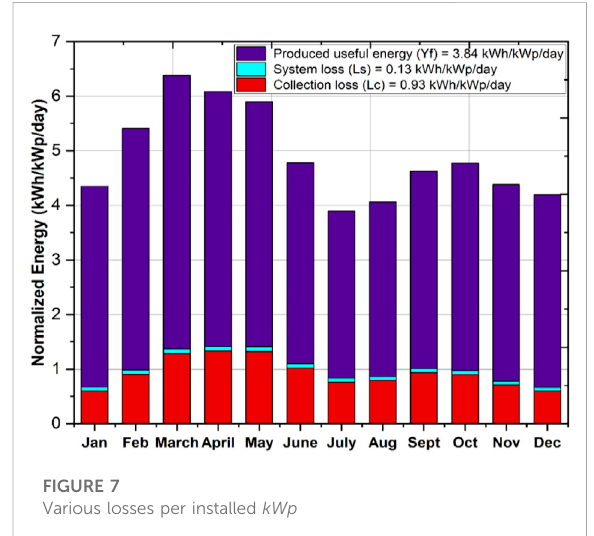
FIGURE 7 Various losses per installed